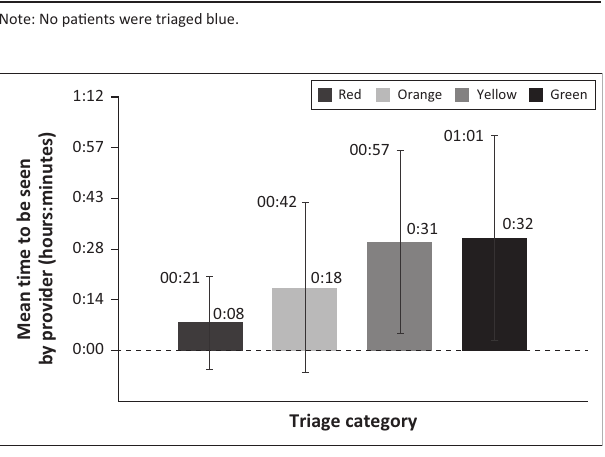
FIGURE 1: Mean times (with standard deviation) for patients to be seen by emergency centres doctor per triage category in a private emergency centre in South Africa in